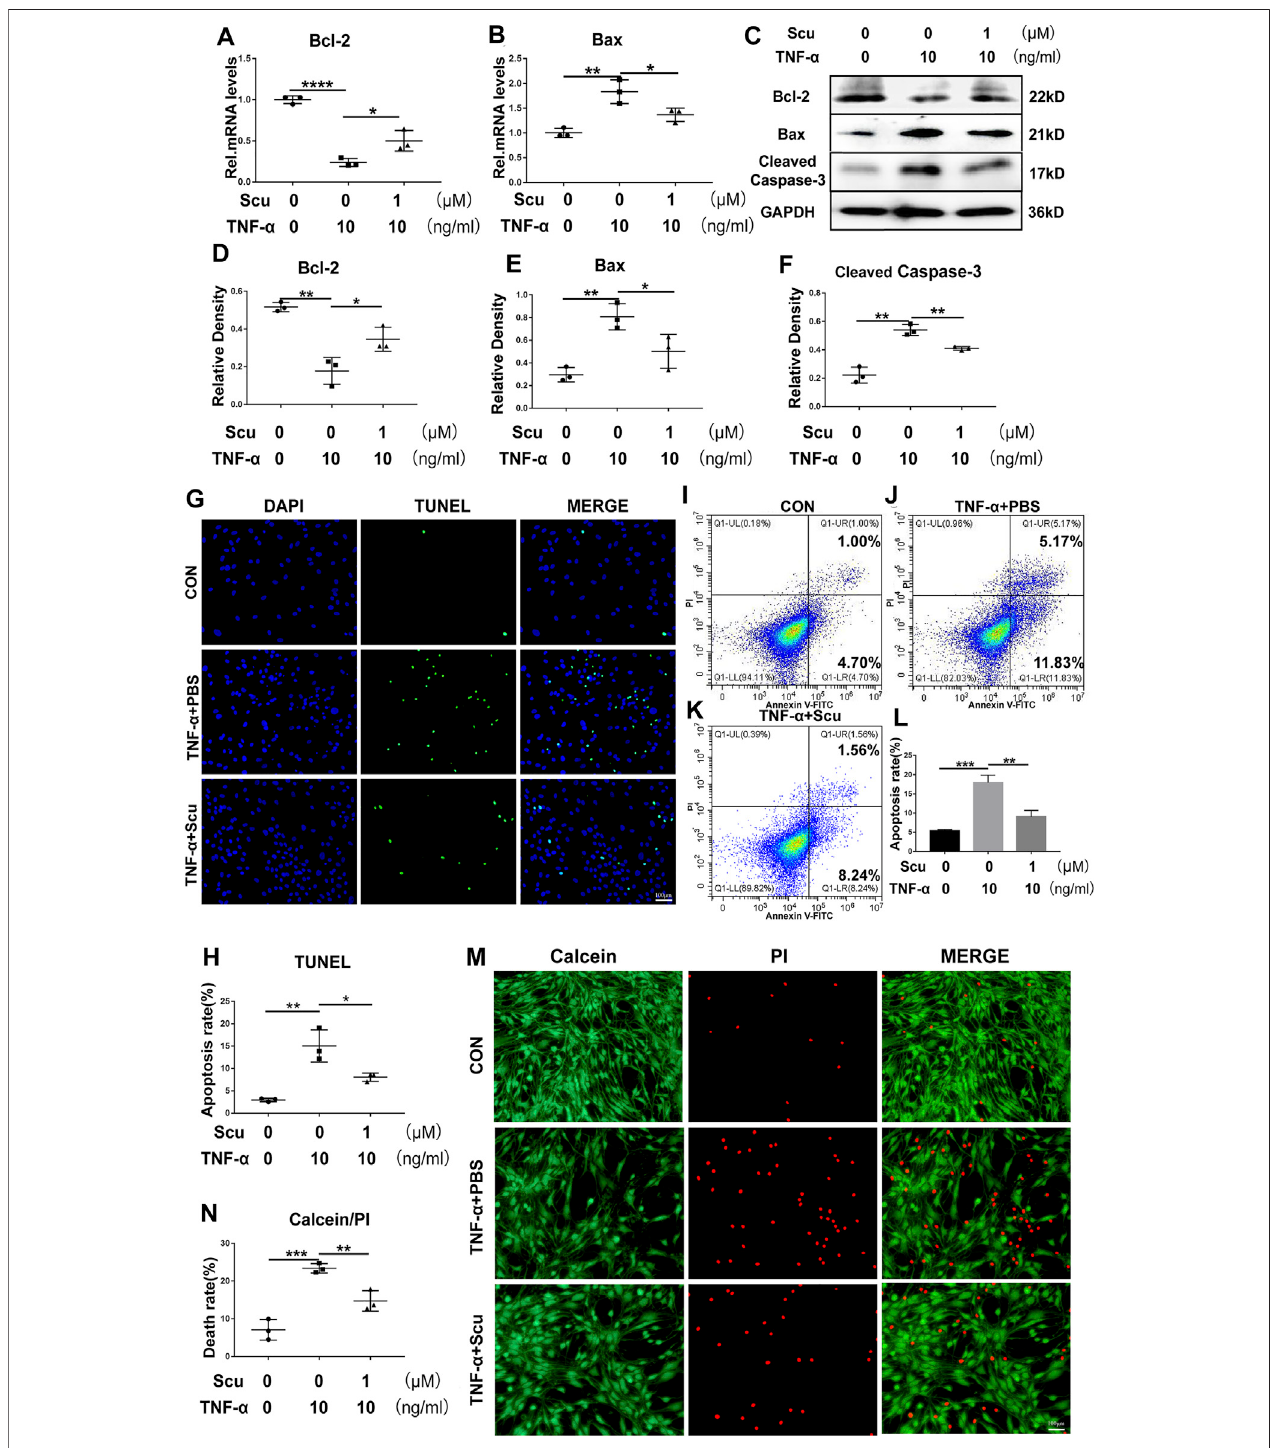
FIGURE 3| Scutellarin treatment suppressed TNF- α -mediated apoptosis in HNPCs. (A,B) HNPCs were stimulated with PBS, TNF- α (10 ng/ml), TNF- α (10 ng/ml) +scutellarin (1 μ M) for 24 h. Total RNA was extracted from each group, and the mRNA expression of Bcl-2 and Bax was assayed using real-time PCR. (C – F) HNPCs weretreatedasindicatedfor48 h.Totalprotein wasextracted fromeach groupofHNPCs, and theproteinexpression levels ofBcl-2, Bax,andcleaved caspase-3were assayed using Western blotting. (G,H) TUNEL staining for each indicated group to examine the apoptosis of HNPCs (scale bar: 100 μ m). (I – L) Apoptosis of each indicatedgroup wasdetected by fl owcytometry after treatmentasindicatedfor48 h. (M,N) Calcein/PI stainingwasperformed todetect thedeath ofHNPCs treatedas indicated for 48 h (scale bar: 100 μ m). Each experiment was performed three times independently. (* p < 0.05, ** p < 0.01, *** p < 0.001).